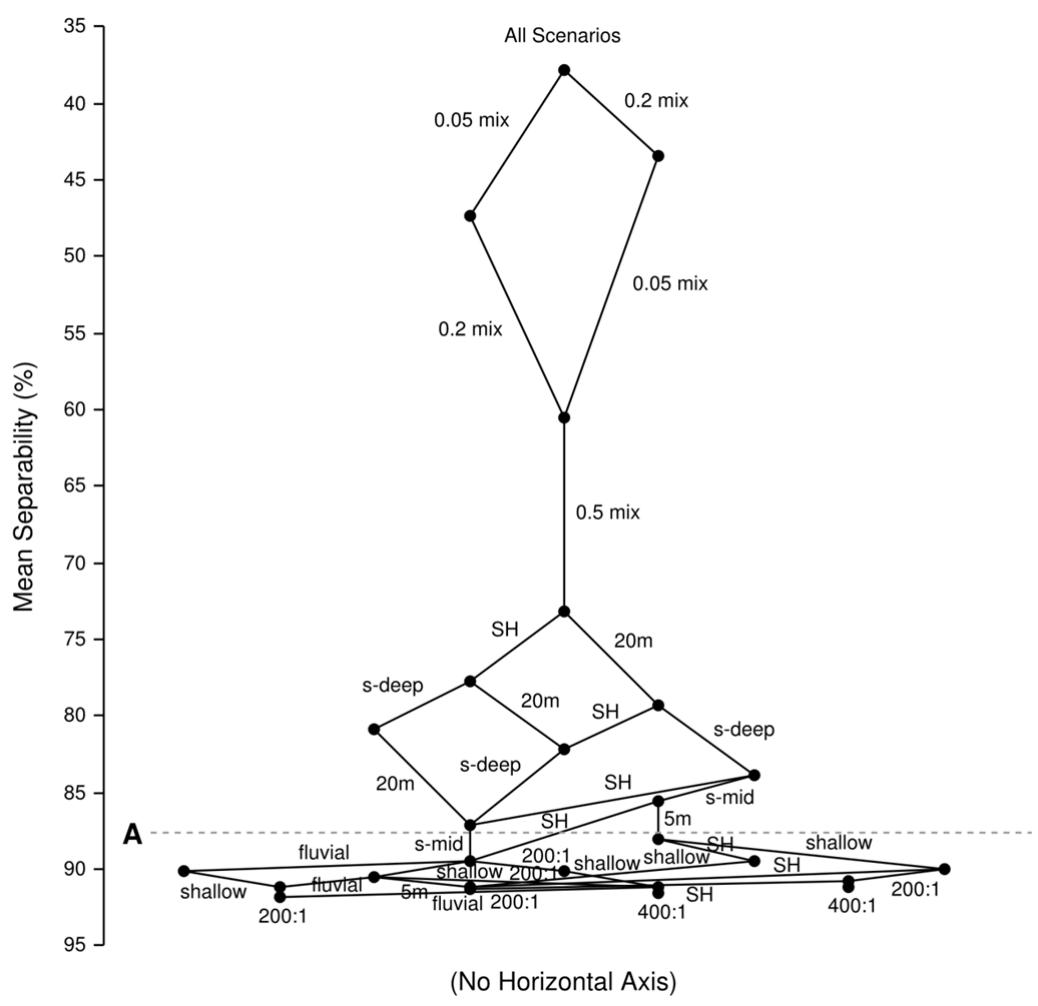
Figure 13. Hierarchical factor diagram for separability of Macroalgae from Live